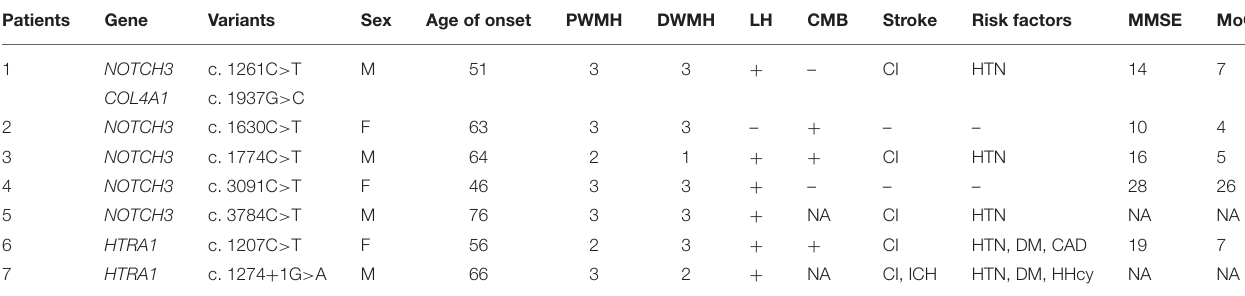
TABLE 2 | The clinical characteristics of the 7 SVD patients with pathogenic variants.